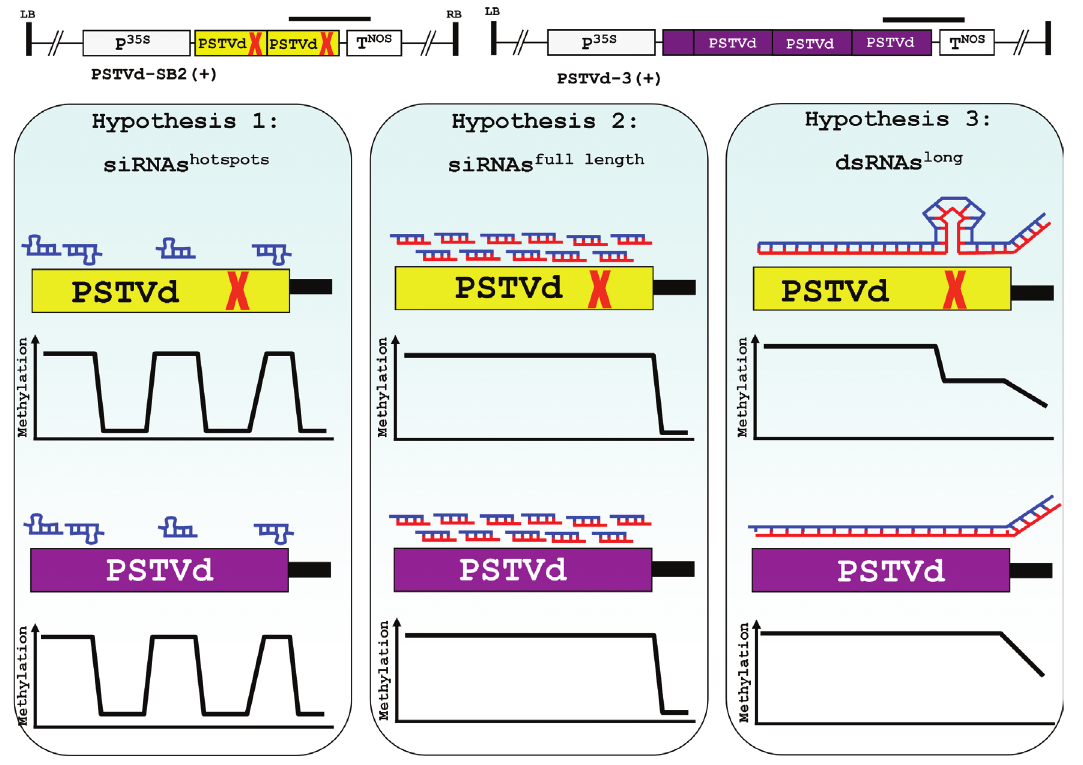
Figure 2 Models of viroid-induced RdDM. As exemplified by the PSTVd-SB2(+) and PSTVd-3(+) transgenes, three different hypotheses are described. Both transgenes are under the control of the Cauliflower mosaic virus (CamV) 35S promoter and of the nopaline synthase (NOS) terminator. The PSTVd-SB2(+) transgene contains a dimeric PSTVd cDNA with a 26-bp deletion (red X). Its primary transcript is not infectious. PSTVd-3(+) carries a trimeric PSTVd, and its transcripts are further processed into mature viroid RNA. The expected methylation patterns of the transgene regions (indicated by a black bar) that are established upon viroid infection are discussed (see main